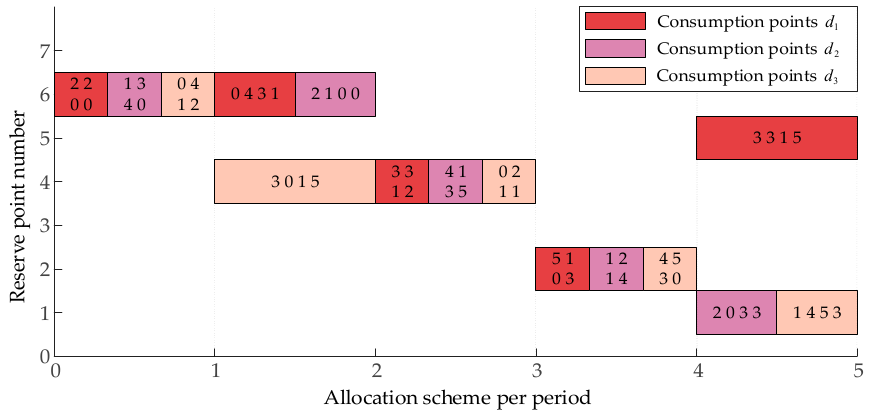
Figure 9. The optimal allocation scheme when w = 1 in Sce